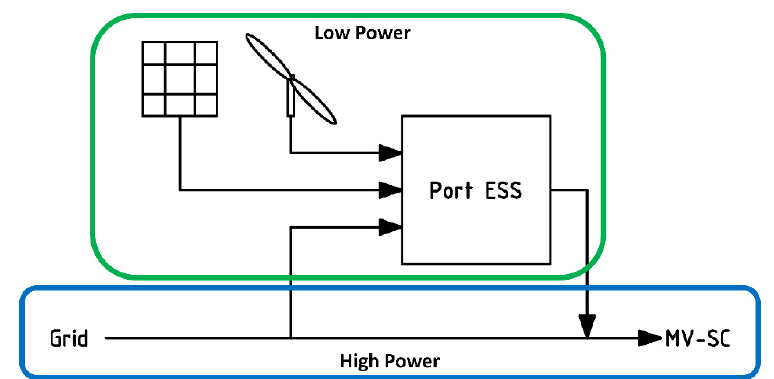
Figure 7. Integration among ESS, renewable sources, grid and MV-SC; first approach.